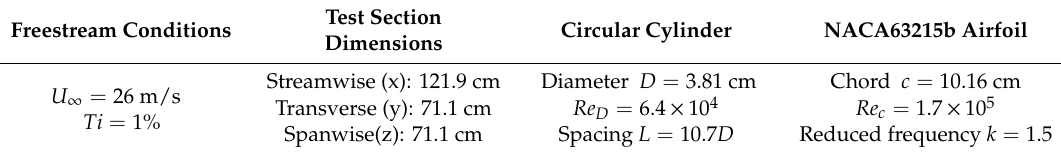
Figure 4. Pressure recovery along the centerline in cylinder wake. Table 2. Test section flow conditions and surrogate model parameters.